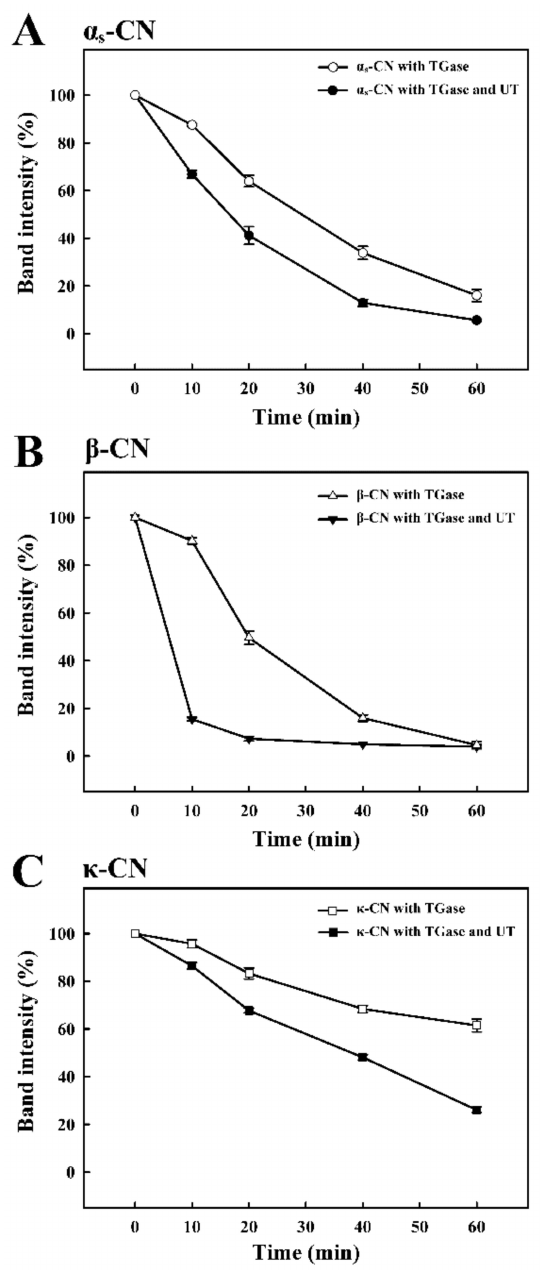
Figure 4. Densitogram corresponding to SDS-PAGE analyses of individual α s -CN, β -CN and κ -CN treated with TGase (6.0 units/mL) and UT at 30 ◦ C for 0, 10, 20, 40 and 60 min. ( A ) α s -CN with TGase and with/without UT, ( B ) β -CN with TGase and with/without UT, and ( C ) κ -CN with TGase and with/without